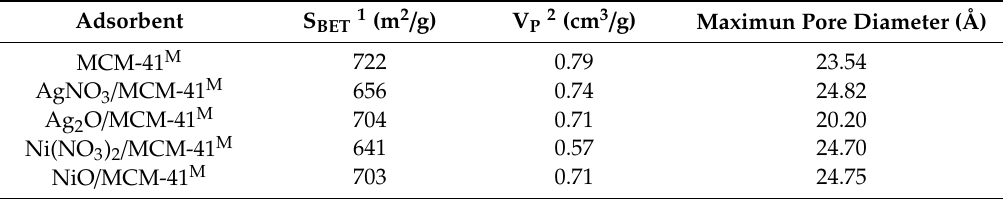
Table 1. Textural properties of the studied samples.